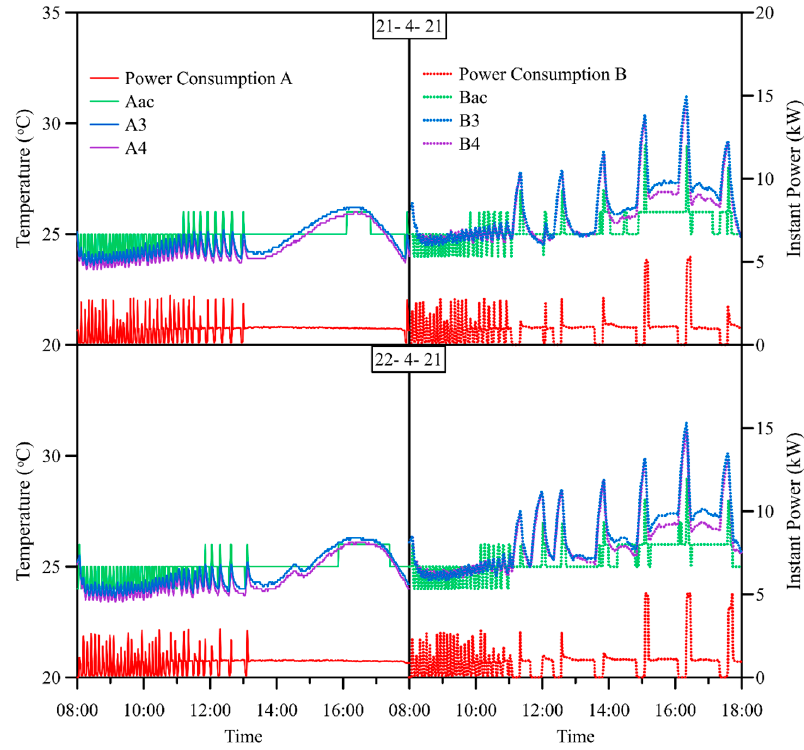
Figure 8. Temperature and instant power consumption of rooms A and